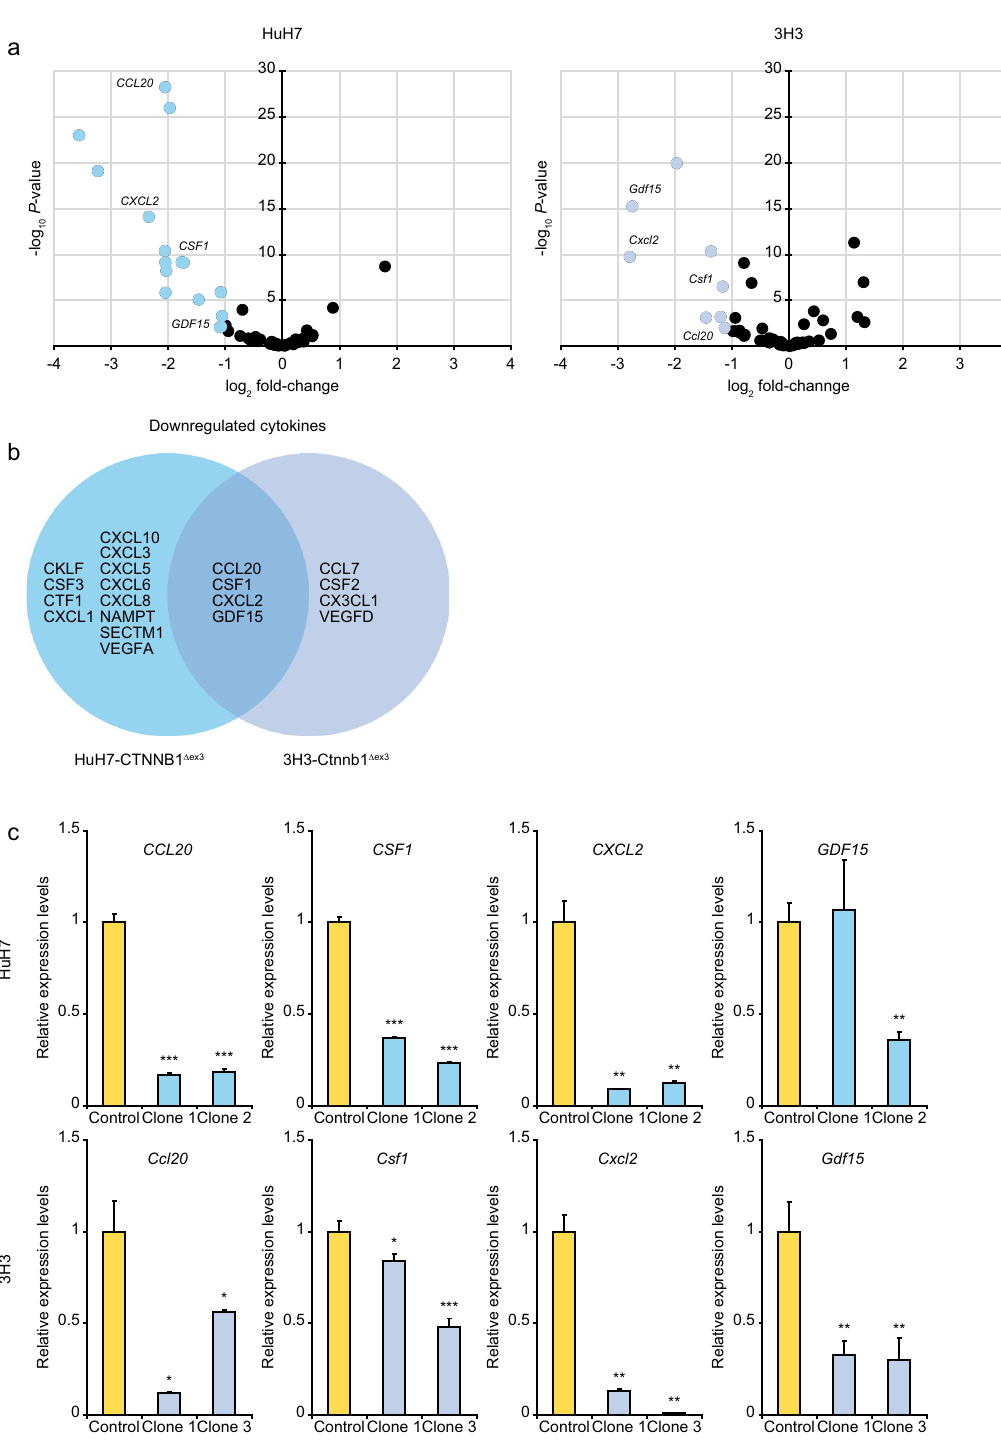
Figure 4. Downregulation of cytokines in human and mouse HCC cells with exon 3 skipping of β-catenin. ( a ) Volcano plots of differentially expressed cytokine genes between the HuH7 and 3H3 cells with and without β-catenin signaling activation. ( b ) Venn diagram of cytokine genes downregulated in the HuH7- CTNNB1 Δex3 and 3H3-Ctnnb1 Δex3 cells. Twenty and sixteen genes were extracted from 114 genes registered in the CYTOKINE ACTIVITY gene set (fold-change < 0.5 and P -value < 0.01). ( c ) Quantitative PCR analysis of four candidate cytokine genes downregulated by β-catenin signaling activation. Error bars are the mean ± SD. P -values were calculated by Welch’s t test. * P < 0.05; ** P < 0.01; *** P <